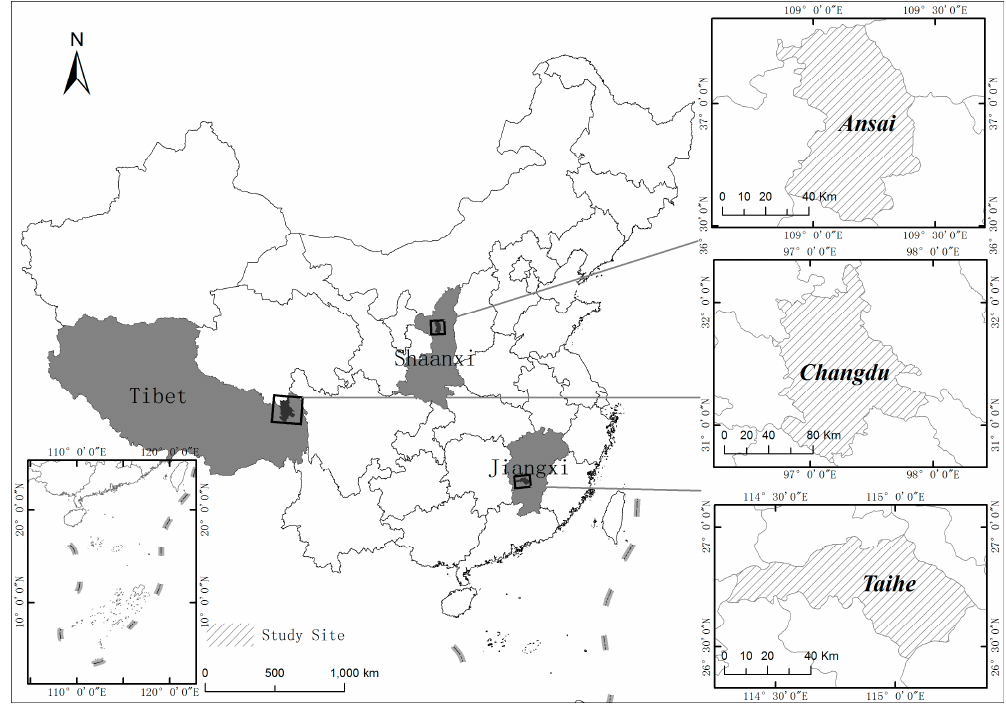
Figure 1. Locations of study sites.